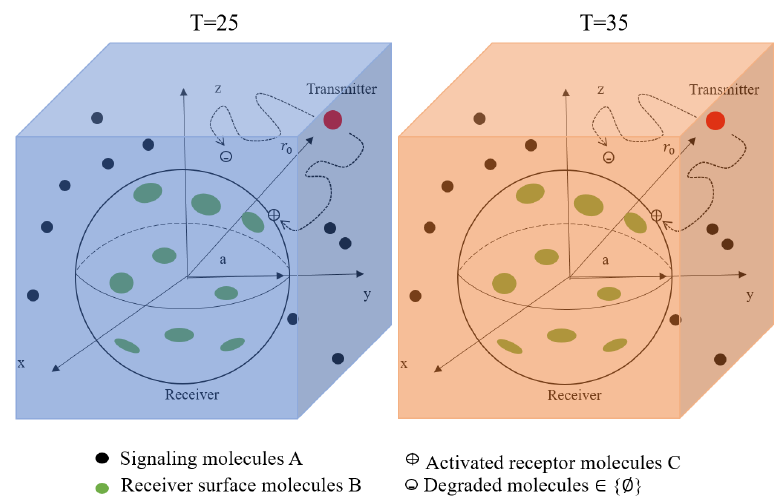
Figure 3. System model with homogeneous temperature distribution.